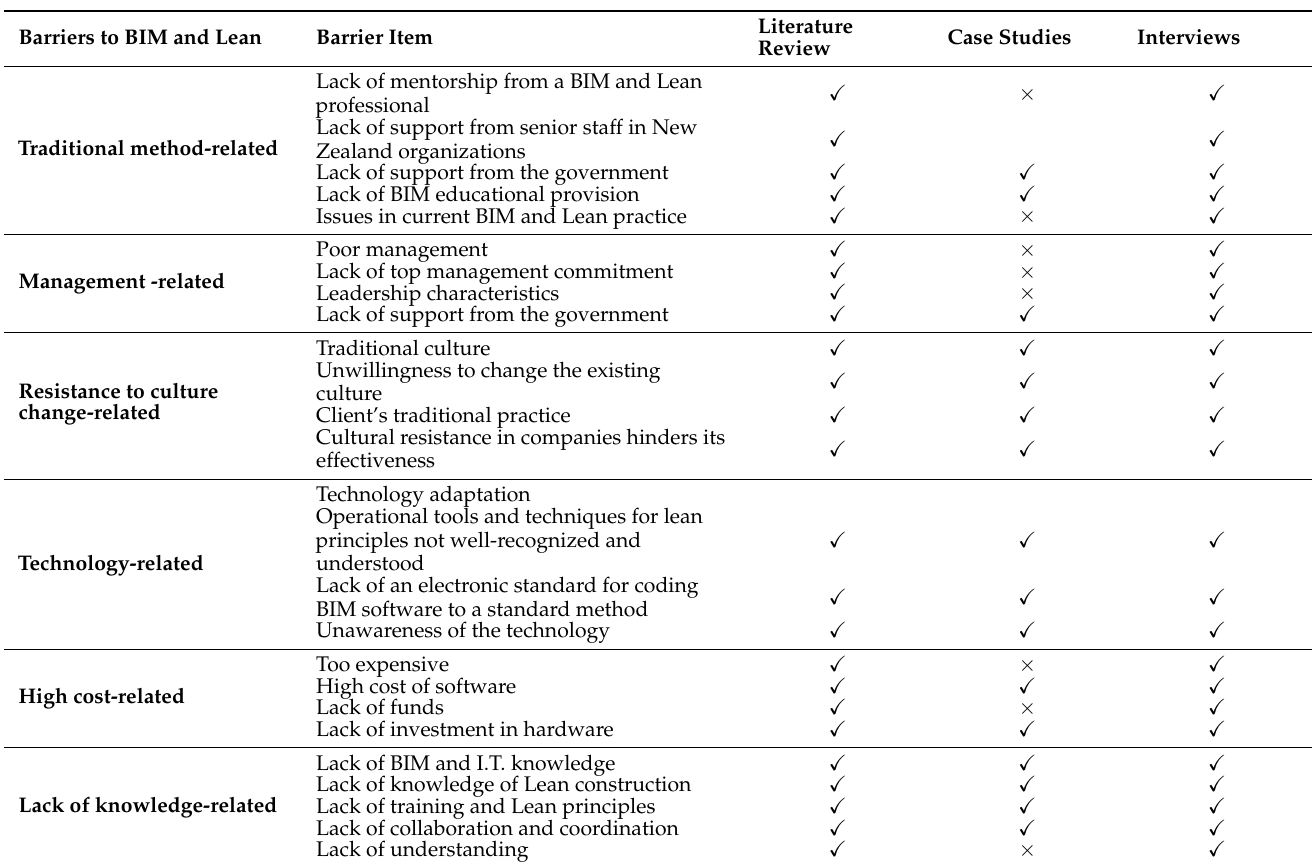
Table 8. Common barriers to BIM and Lean